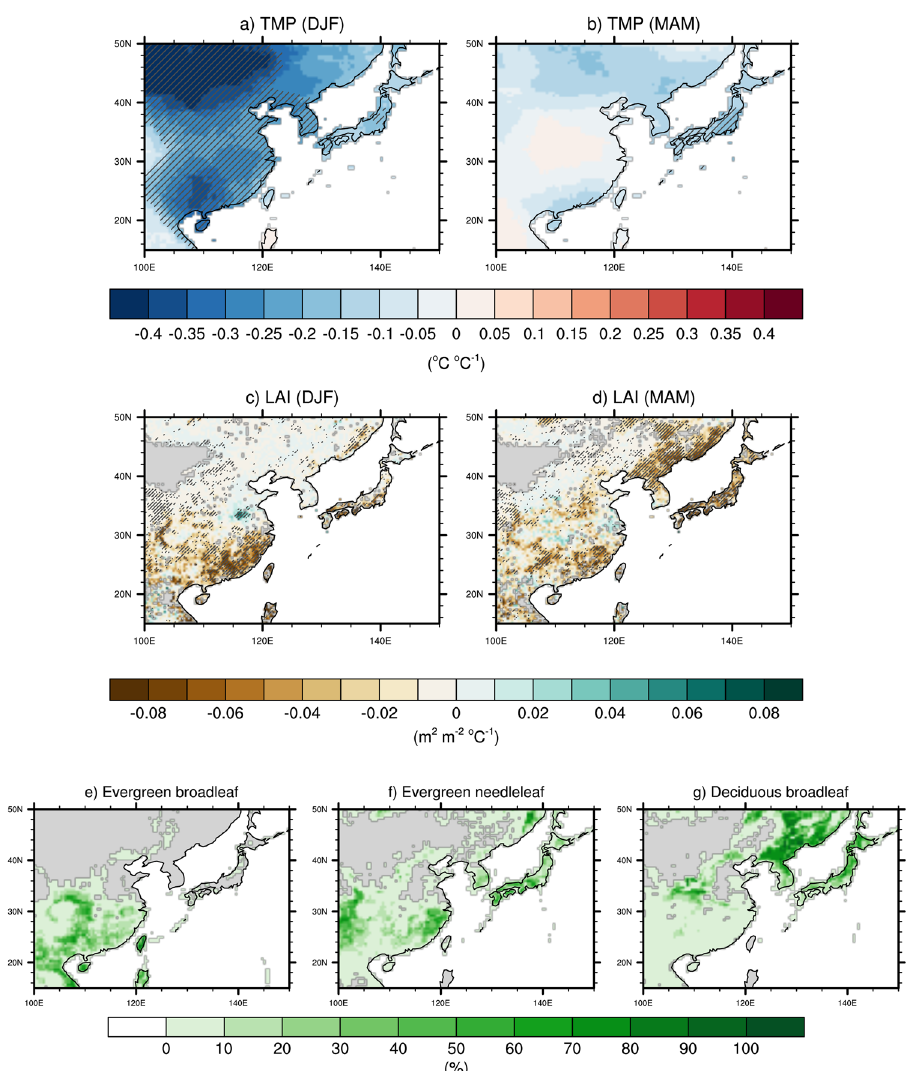
Fig. 2 Temperature and leaf area index anomaly related to Arctic warming. a – d Regression coef fi cients of seasonal mean temperature (°C °C − 1